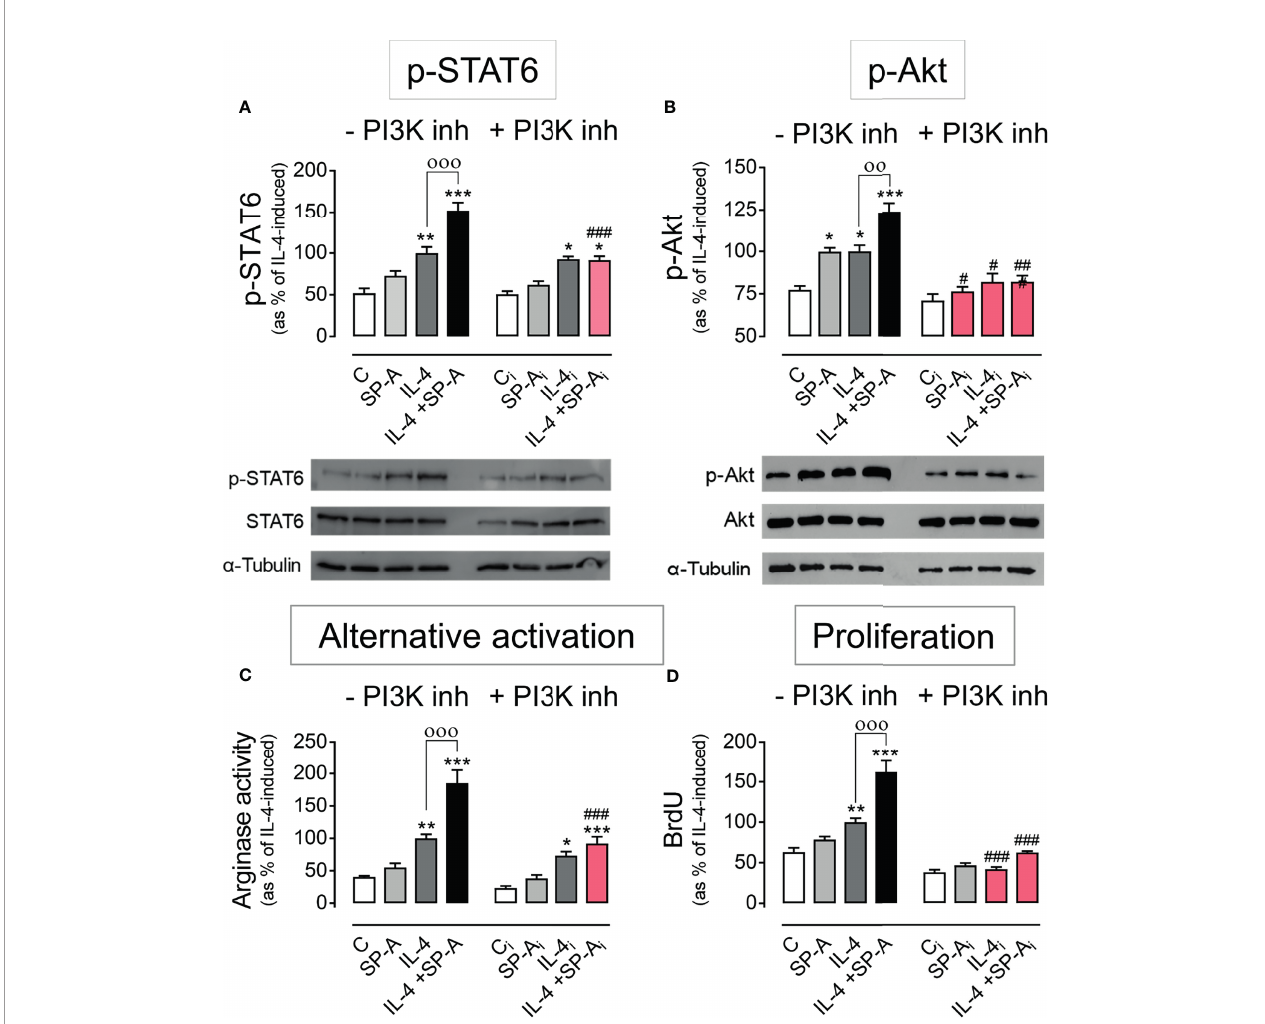
FIGURE 2 | PI3K inhibition abrogates SP-A effects on IL-4 signaling. Puri fi ed rat AMs were pretreated with 50 nM LY294002 (PI3K inhibitor) or vehicle (DMSO) for two hours. Subsequently, cells were stimulated with or without IL-4 (1 m g/ml) in the presence or absence of SP-A (100 m g/ml) and exposed to 10 m M BrdU for proliferation analysis. Quanti fi cation of (A) p-STAT6 (Tyr641) relative to total STAT6, (B) p-Akt (Ser473) relative to total Akt, (C) arginase activity, and (D) BrdU incorporation in the newly synthesized DNA of AMs. A representative Western blot for p-STAT6 and p-Akt is shown below each graph. The results are presented as means (± SEM)